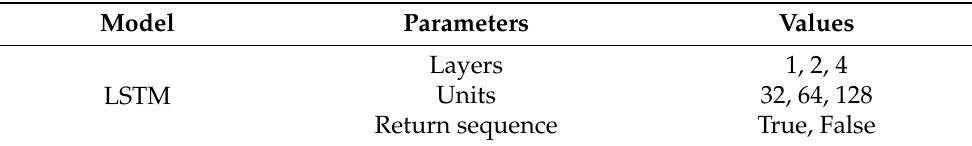
Table 2. Grid of parameters used for LSTM models.